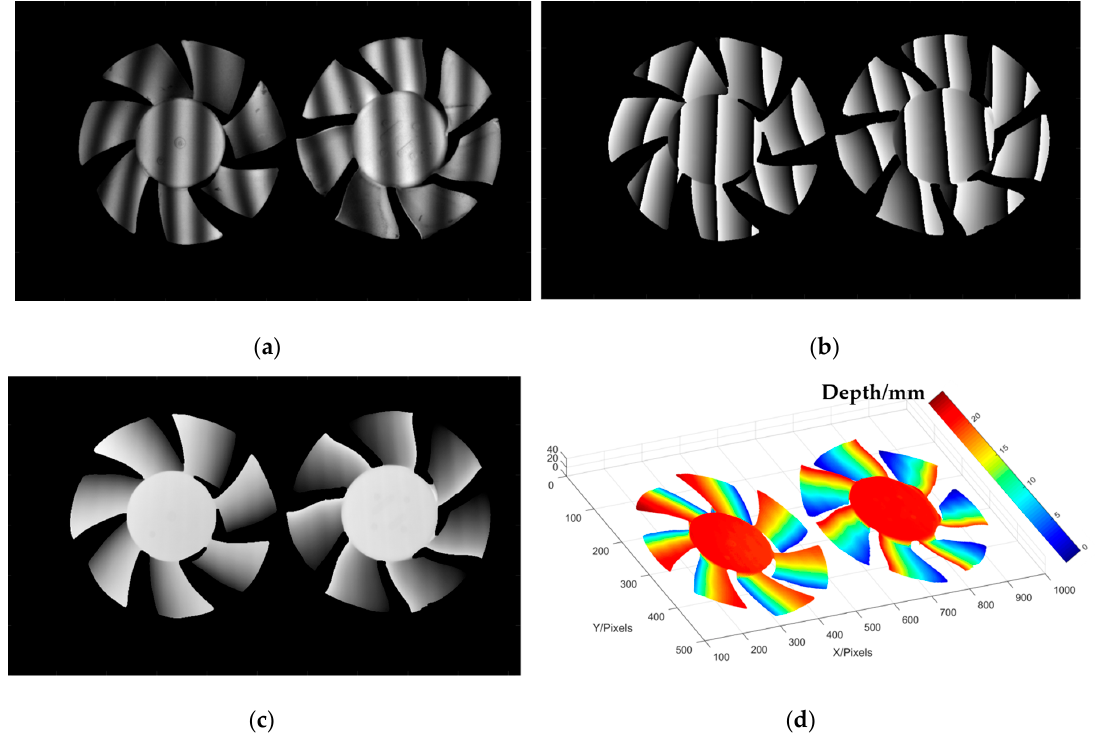
Figure 7. Measurement of the isolated objects by this proposed method. ( a ) One captured sinusoidal image of the measured scene; ( b ) Wrapped phase of the measured scene; ( c ) Absolute phase of the measured scene; ( d ) Reconstructed result of measured scene.